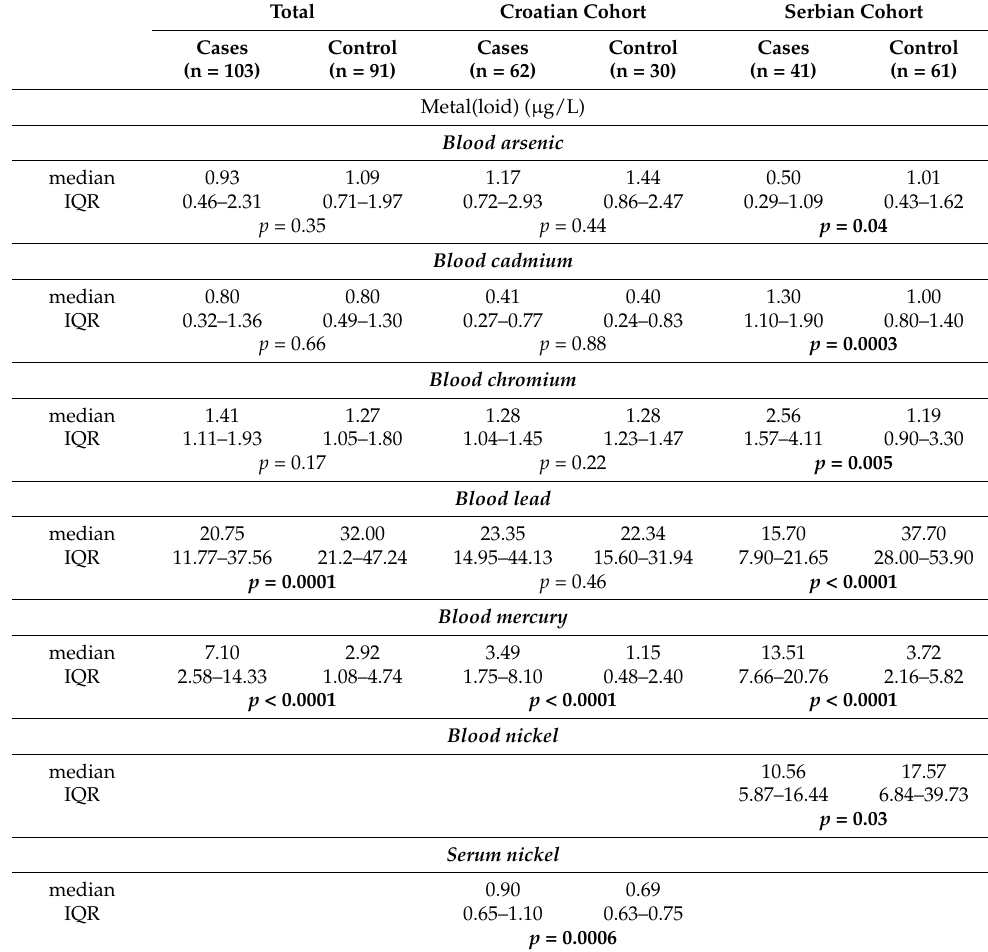
Table 2. Concentration of arsenic (As), cadmium (Cd), chromium (Cr), mercury (Hg), nickel (Ni), and lead (Pb) in whole blood and Ni in serum of men with prostate cancer (cases) and